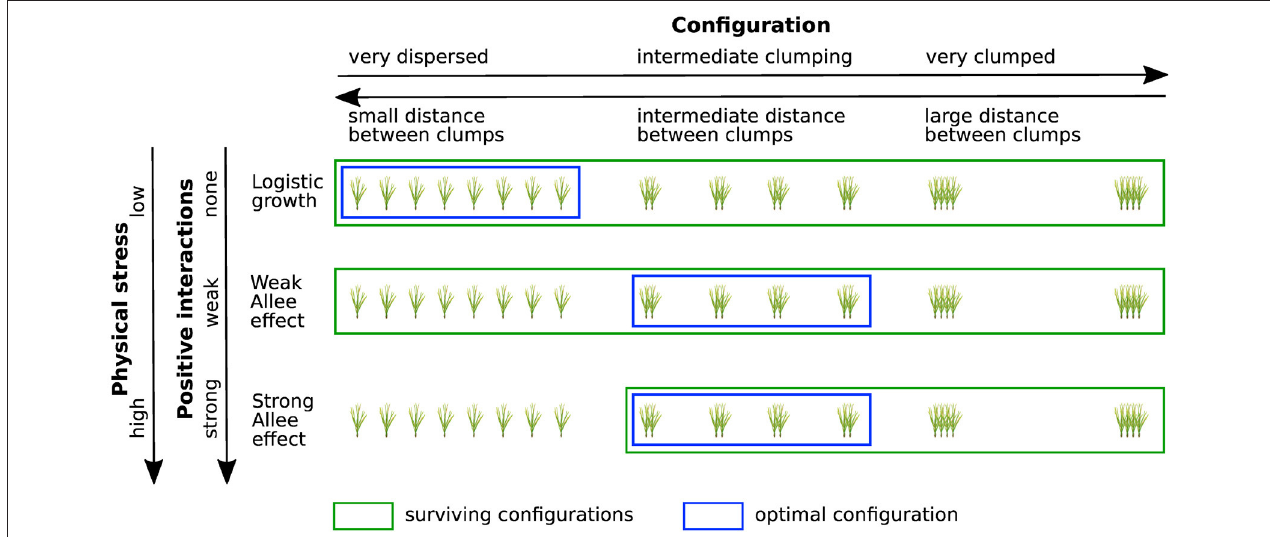
FIGURE 6 | Conceptual visualization of the performance of clumped and dispersed restoration designs in relation to the strength of positive interactions. Green boxes indicate surviving configurations, blue boxes indicate the most efficient method of planting for each growth function. If population dynamics follow logistic growth (no positive interactions) optimal restoration is achieved for a dispersed planting configuration with small distances between clumps. In the presence of an Allee effect optimal performance is obtained for intermediate clumping, while too clumped configurations yield bad restoration performance for all growth functions. According to the Stress Gradient Hypothesis positive interactions (e.g., facilitation) become more significant with increasing physical stress. Thus, although it is not explicitly included into our model, the strength of the Allee effect (none, weak, strong) can be considered as a proxy for physical stress, allowing us to draw conclusions on expected restoration success in different stress